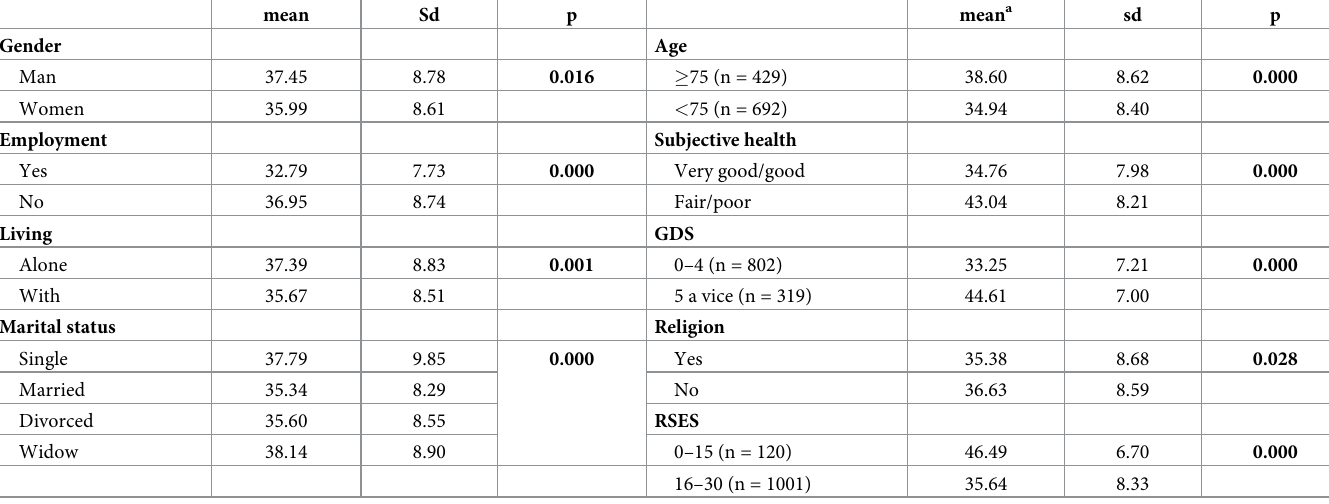
Table 2. Evaluation of differences in life satisfaction according to selected factors.